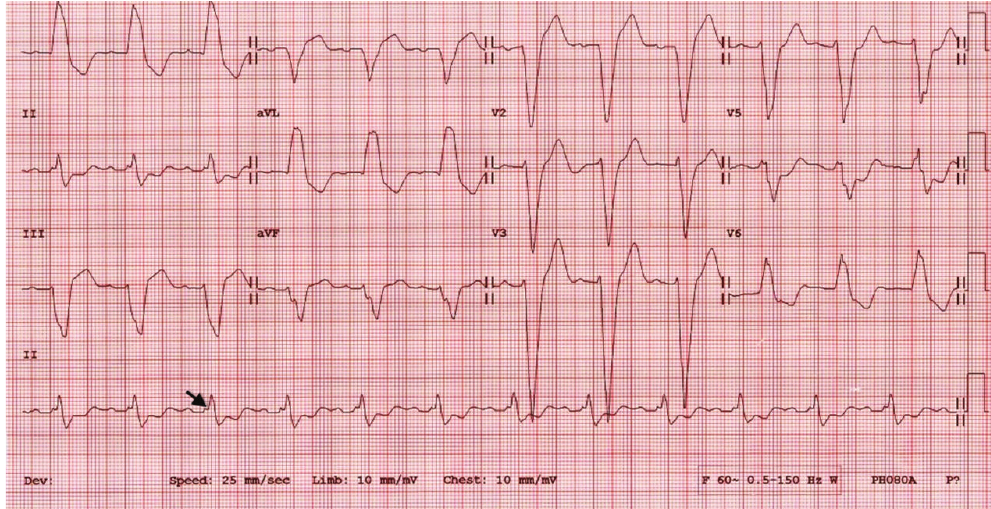
Figure 2: Baseline ECG from CRT super responder showing several predictors of good response including sinus rhythm, long PR interval, typical LBBB with mid-QRS slurring in lateral leads, QRS duration > 200ms, and long LVAT max measured by subtracting RVAT from the QRS duration. Arrow indicates the end of